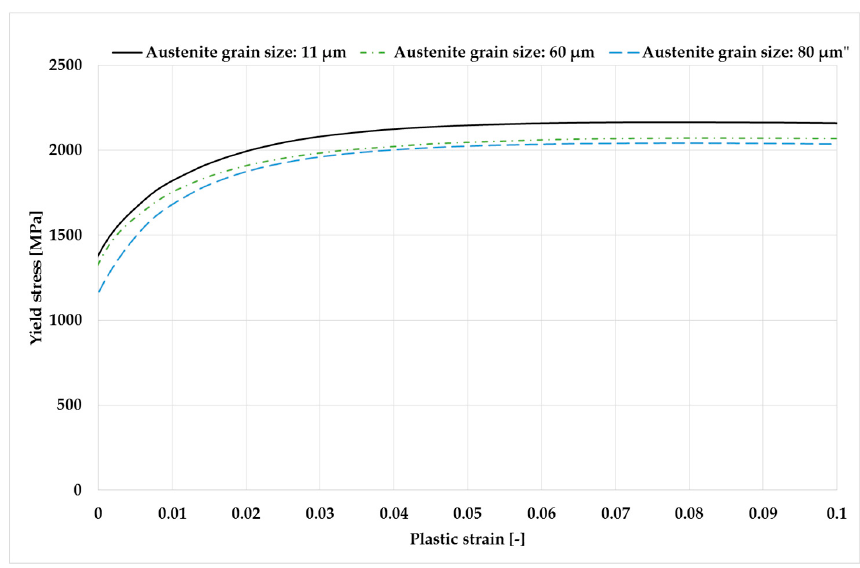
Figure 11. Flow curves at room temperature and strain rate of 0.01 s − 1 .